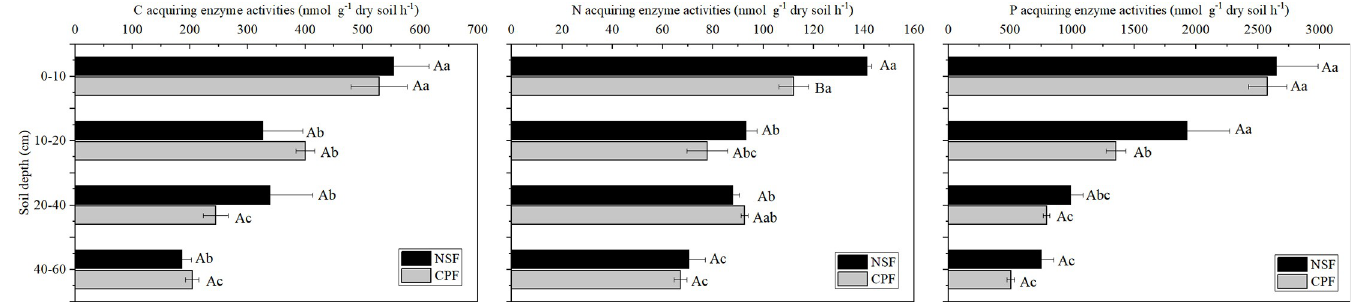
Fig 2. Variations of C, N and P acquiring enzyme activities at different soil depths of the natural secondary forest (NSF) and Chinese fir plantation forest (CPF). Statistically significant differences were assumed at p < 0.05. All values are presented as mean ± standard error (n = 3). Capital letters show the significant difference between the two forests at the same soil depth, and the different lower cases reflect the significant difference between soil depths within one forest.